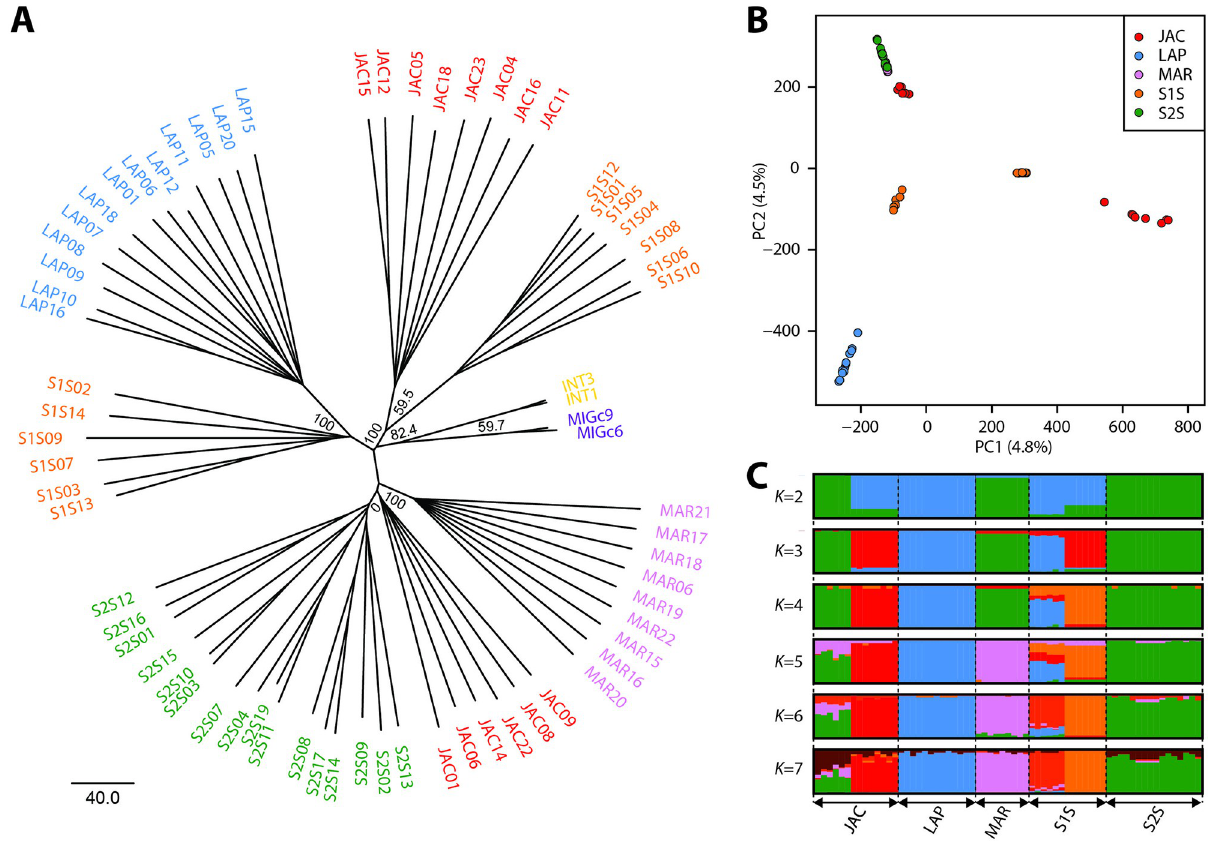
Fig 3. Lutzomyia longipalpis population structure. Inferred population structure of Lu . longipalpis individuals collected from Marajo´ (MAR; pink), Lapinha (LAP; blue), from Jacobina (JAC; red), and Sobral, including Sobral 1S (S1S; orange) and 16 Sobral 2S (S2S; green). (A) Rooted neighbor joining (NJ) radial tree. We included both N . intermedia (INT; yellow) and M . migonei (MIG; purple) and used M . migonei to root the trees. Bootstrap values represent the percentage of 1,000 replicates. (B) Principal component analysis (PCA). Individuals were plotted according to their coordinates on the first two principal components (PC1 and PC2). (C) Admixture analysis. Ancestry proportions for Admixture models from K = 2 to K = 7 ancestral populations. Each individual is represented by a thin vertical line, partitioned into K coloured segments representing the individual’s estimated membership fractions to the K clusters. These data are the average of the major q -matrix clusters derived by CLUMPAK analysis.